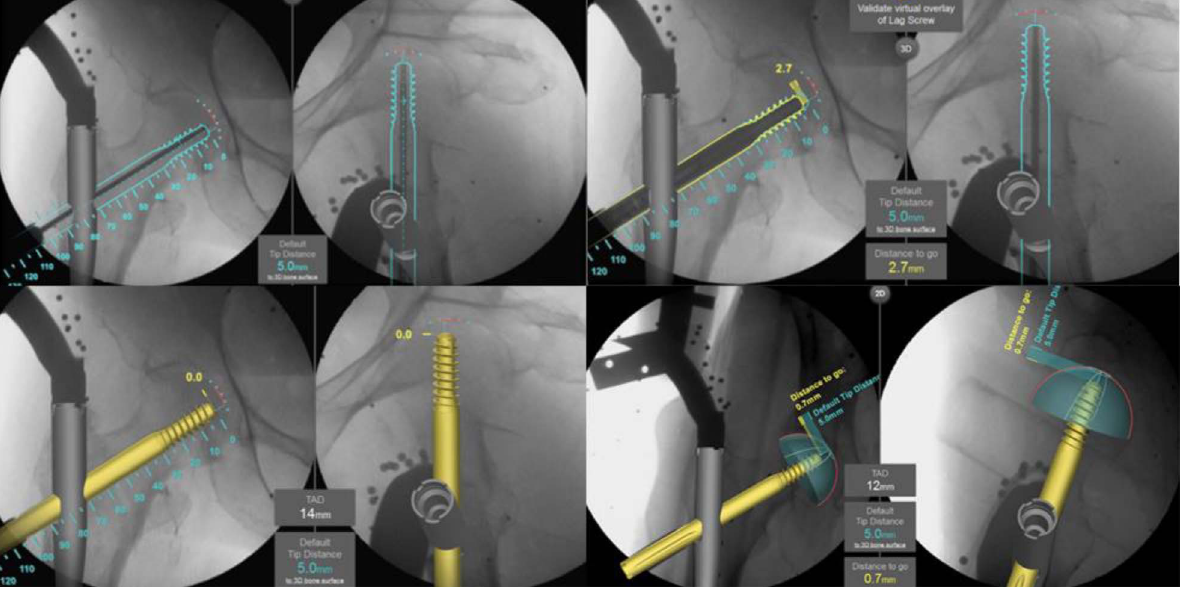
Figure 3. After inserting the guidewire along the outline displayed on the ADAPT monitor, the predicted position and length of the lag screw are displayed in a setting where the TSD is 5 mm. When the lag screw is actually inserted, the display shows how many more mm it needs to be inserted before the TSD will be in the 5 mm position. In addition, TAD can be checked at any time during the operation. After the lag screw has been installed, the position of the lag screw is displayed in 3D.